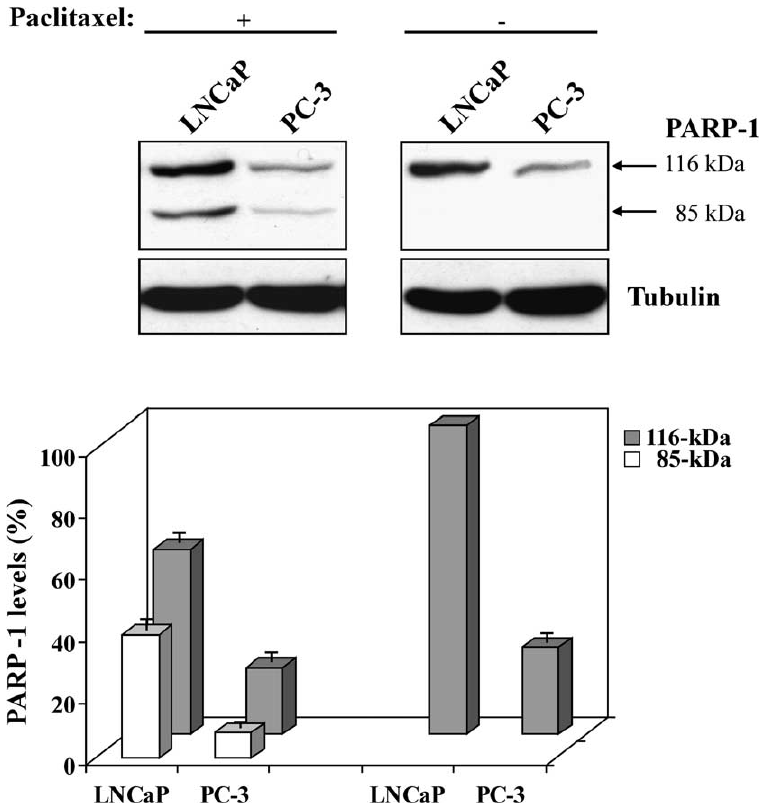
Fig. 3. PARP-1 expression is reduced in androgen-independent PC-3 prostate cancer cells. PARP-1 cleavage in LNCaP and PC-3 cells treated for 24 h with 10 nM paclitaxel was measured by Western blotting using a monoclonal antibody to PARP-1 that recognizes both the uncut form (116 kDa) and the apoptosis-specific cleaved fragment (85 kDa) of PARP-1. Baseline PARP-1 (116 kDa) expression levels were measured in LNCaP and PC-3 cells grown for 24 h on plastic plates in the absence of paclitaxel ( − ). Blots are representative of three independent experiments. At the bottom, PARP-1 protein levels in PC-3 (mean ± S.E.) are reported as percentage of LNCaP cells, where 100% represents the sum of the 116 and 85 kDa signals in LNCaP cells in presence or absence of paclitaxel. The relative amount of the 116 and 85 kDa bands is